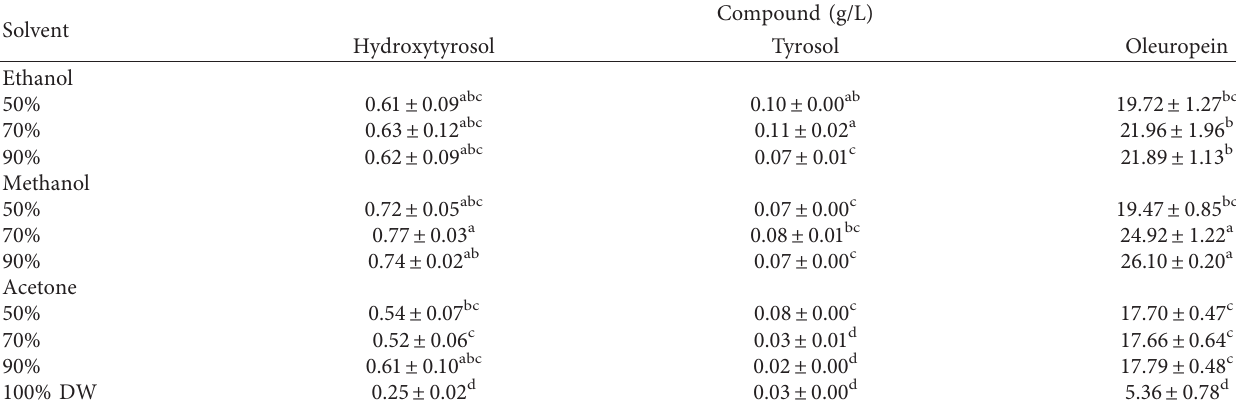
Table 2: Major phenolic compounds in olive leaf extracts obtained using various